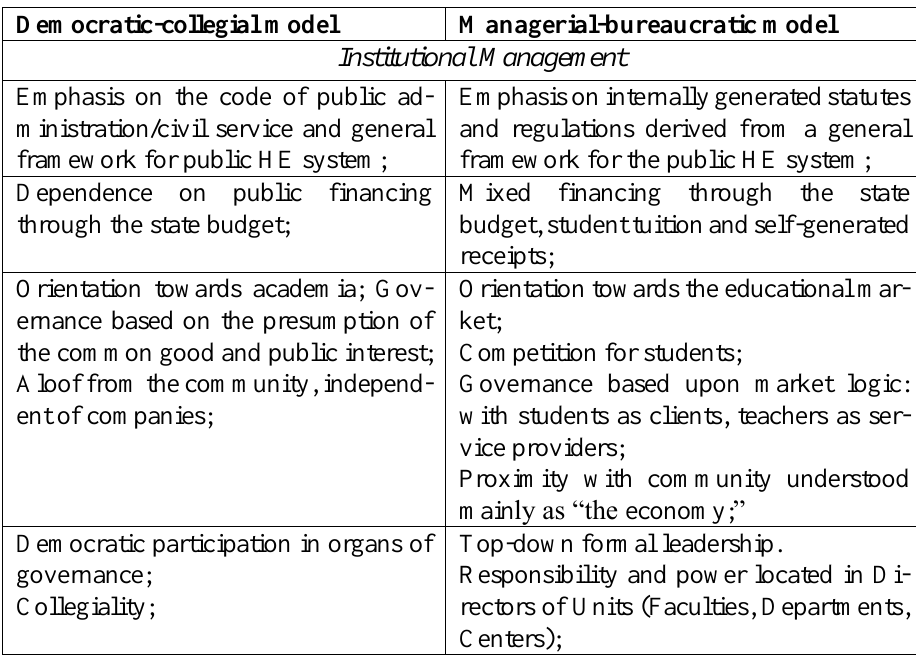
Ideal types of administration models in